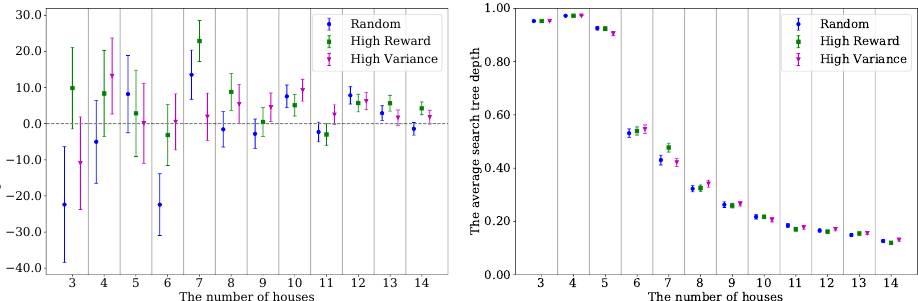
Figure 12. The results of combination strategies experiments for meeting in grid problem. ( left ) The average cumulative reward difference. 0.0 line represents the performance of DecMCTS (cid:101) ( right ) The average depth of the search tree over the problem horizon. The whiskers show the standard error.